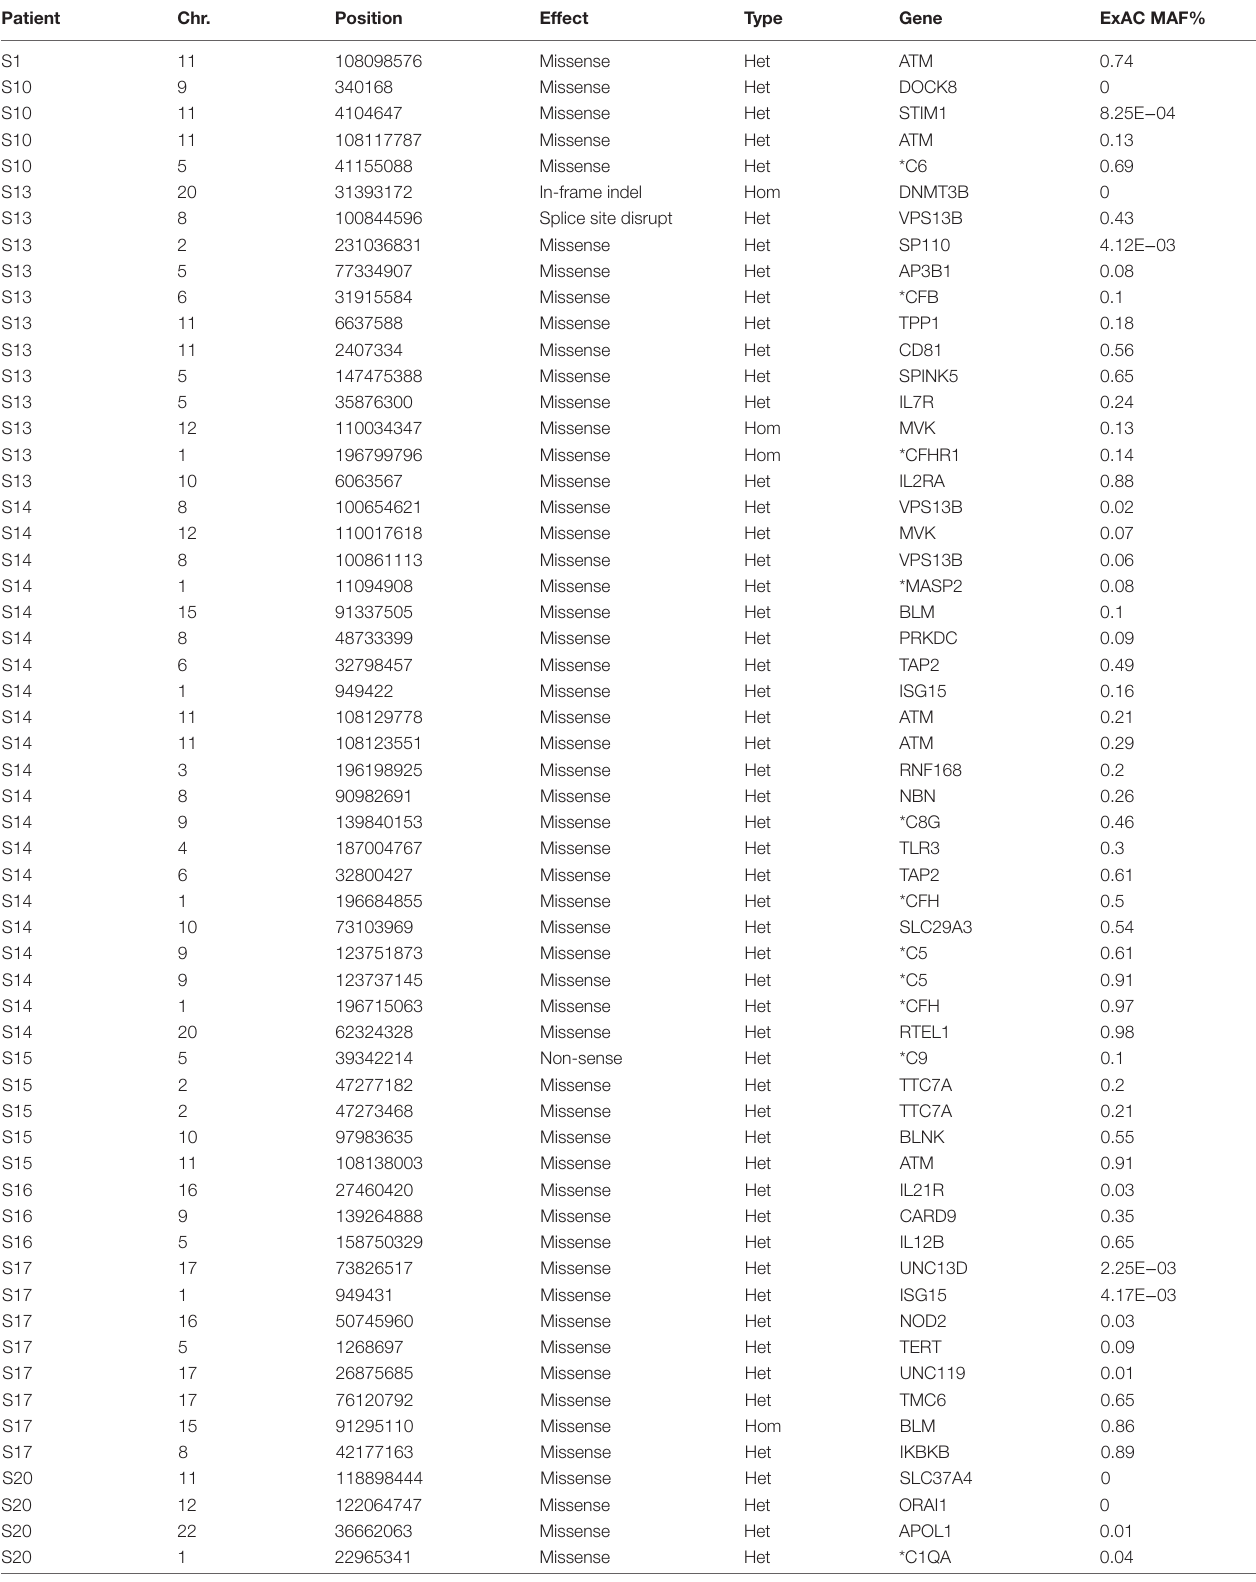
TaBle 5 | 76 rare (exac MaF < 1%) non-synonymous and putative loF variants found in known 252 PiD genes in our 11 patients. Patient